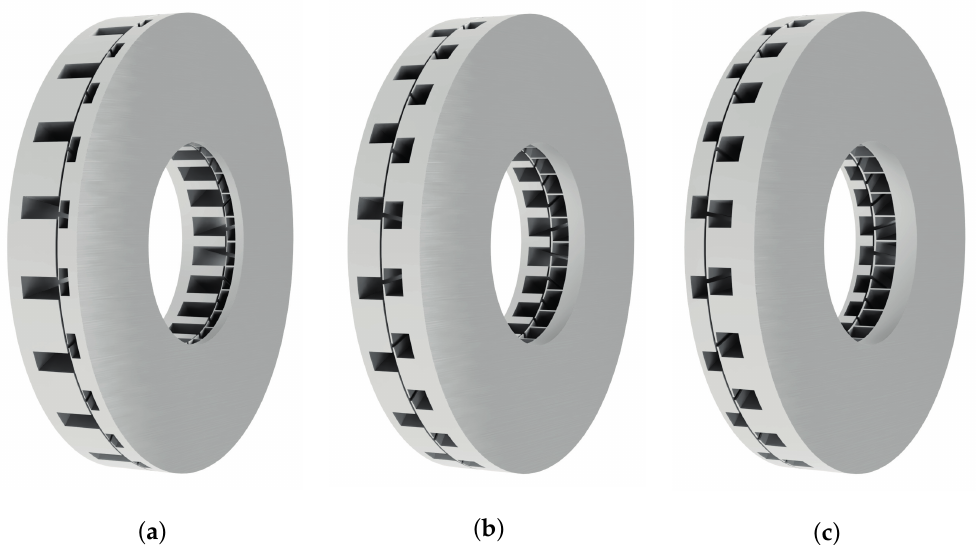
Figure 1. Illustration of a thought experiment. ( a ) Illustration of the Axial Flux Induction Machine (AFIM) in which the stator occupies 80% of the axial length, ( b ) the stator occupies 50% of the axial length, and ( c ) the stator occupies 30% of the axial